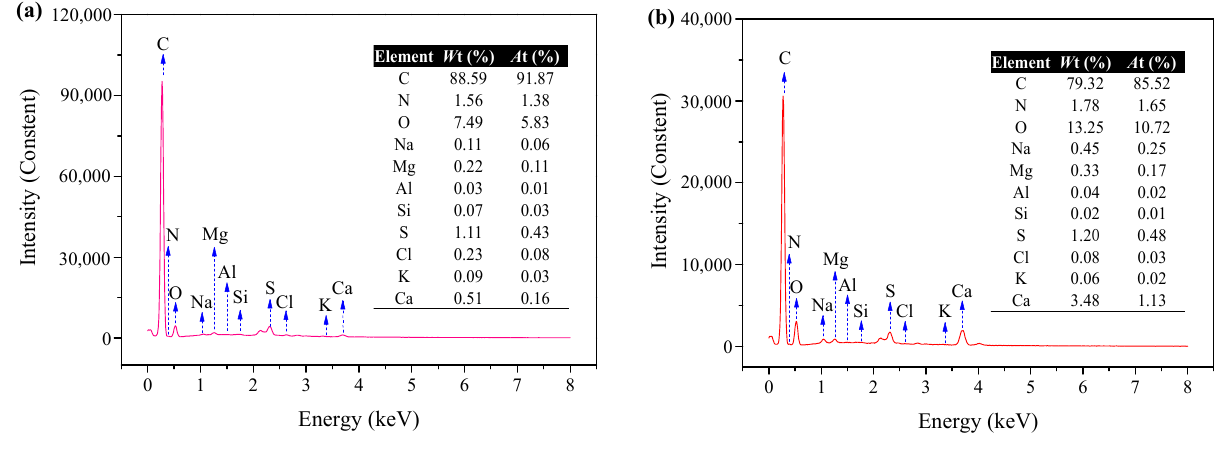
Figure 2. EDS analysis results of ARB ( a ) and M-ARB ( b ).